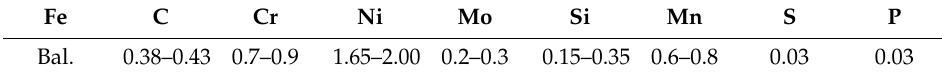
Table 3. Chemical composition of the AISI 4340 powder (in wt %).